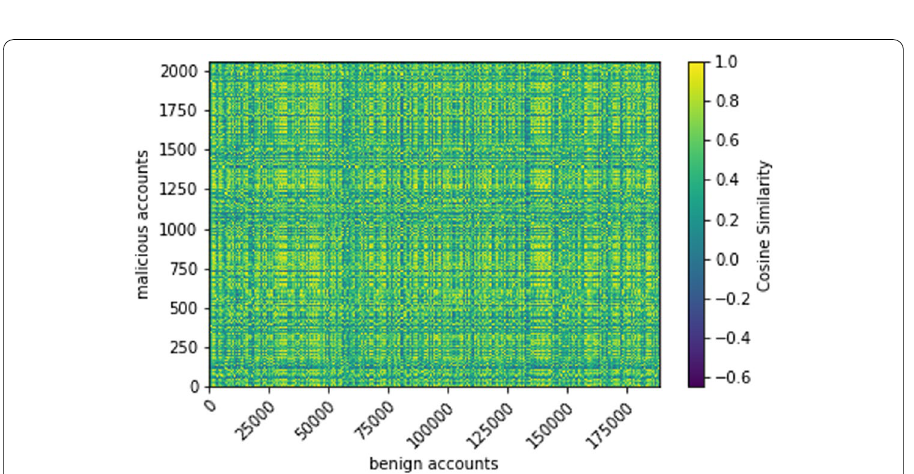
Fig. 12 Cosine similarity between malicious accounts and benign accounts in the cluster with best Silhouette